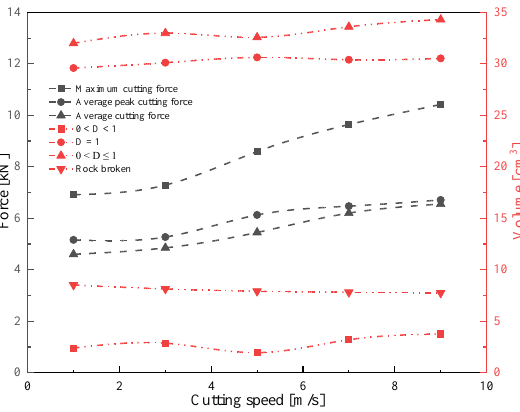
Figure 18. The rock damage and broken volume with various cutting